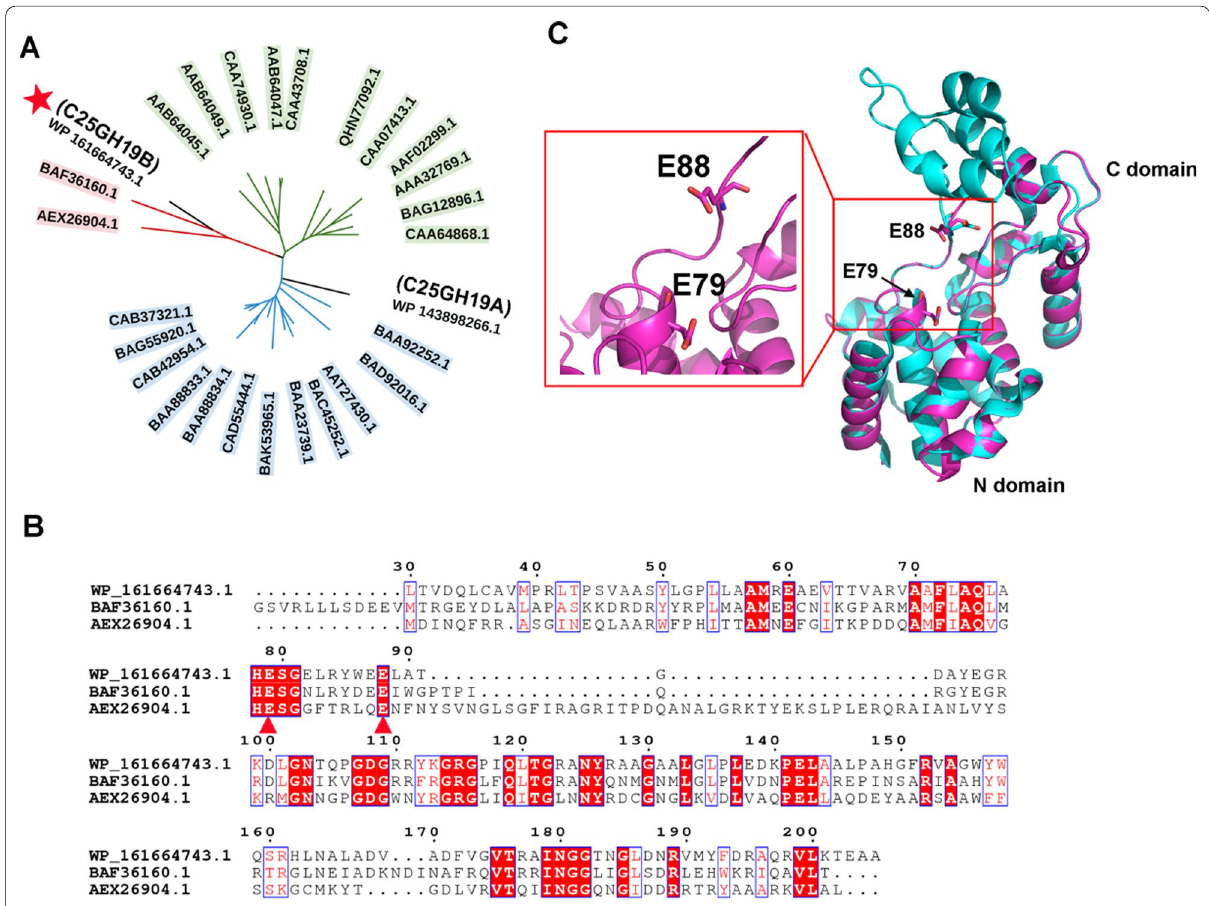
Fig. 2 Sequence and structure analysis of C25GH19B. A Phylogeny of C25GH19B and the well-characterized GH19 enzymes in the CAZy database. The enzymes derived from plants, bacteria, and bacteriophages are shown in green, blue, and red, respectively. C25GH19B is indicated by a red star. B Multiple sequence alignment of C25GH19B and the phage lysozyme (BAF36160.1) and endolysin (AEX26904.1). The catalytic residues are indicated by red triangles. C Superposition of the model structure of C25GH19B (magenta) and the crystal structure of AEX26904.1 (cyan, PDB entry: 4OK7). The predicted catalytic residues of C25GH19B are shown in sticks and labeled